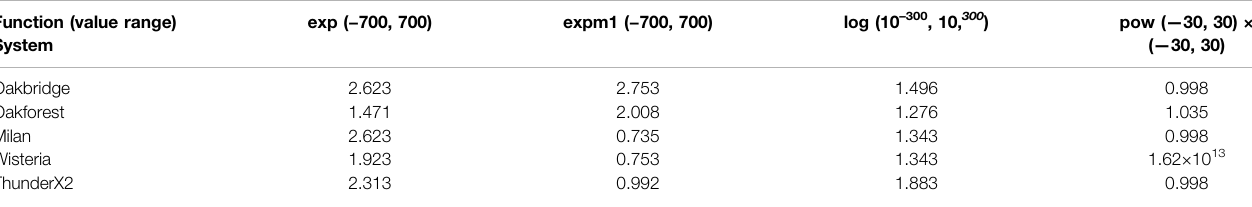
TABLE 5 | Maximum error of vectorised math library calls when evaluating input values in the prescribed ranges. The error is reported in units of least precision (ULPs). Function (value range)